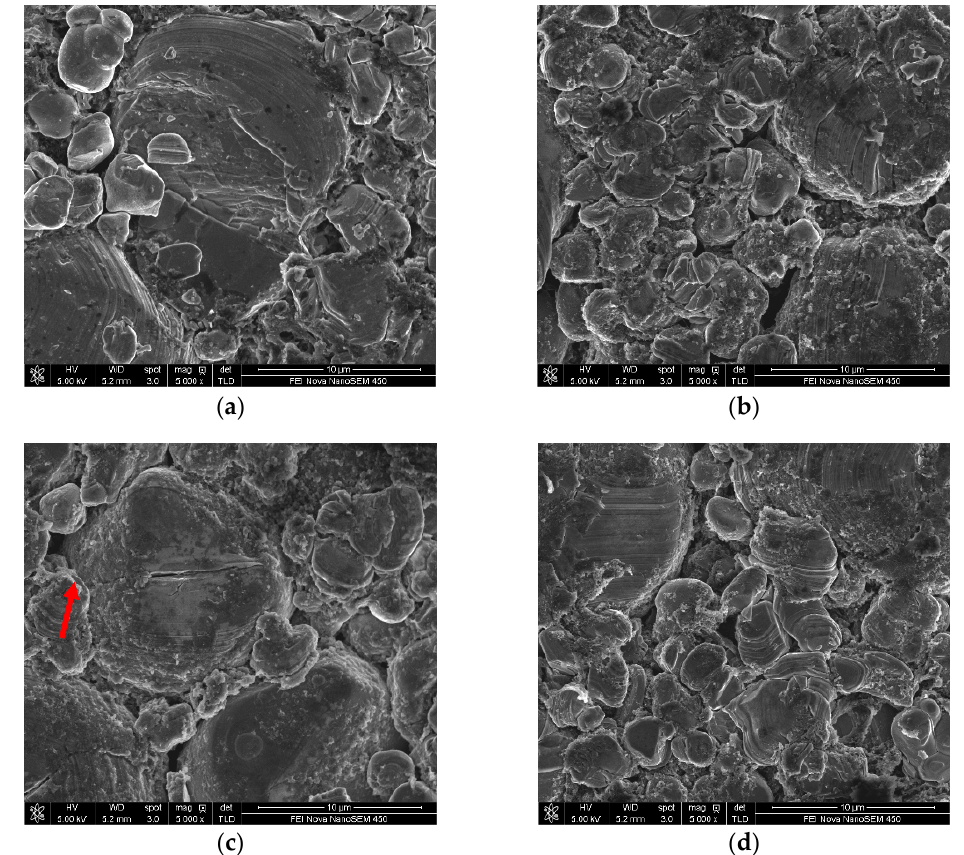
Figure 8. Morphological changes of the electrodes in different electrolyte groups before and after high-temperature (60 °C) storage: ( a ) in #5 EL before storage; ( b ) in #8 EL before storage; ( c ) in #5 EL after storage (the red arrow indicates the obvious cracks presented on the LiCoO 2 particles in the base electrolyte without additive DDDT); ( d ) in #8 EL after storage. Table 4. Surface elemental distributions of the electrodes before and after high-temperature storage.